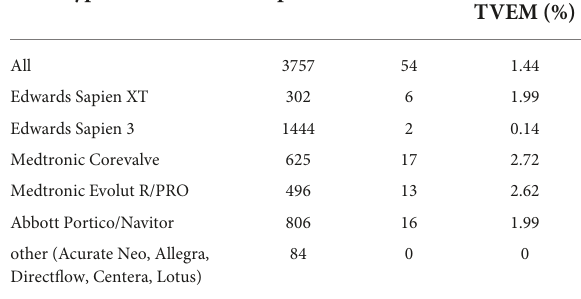
TABLE 1 Distribution of valve types and incidence of transcatheter valve embolization and migration